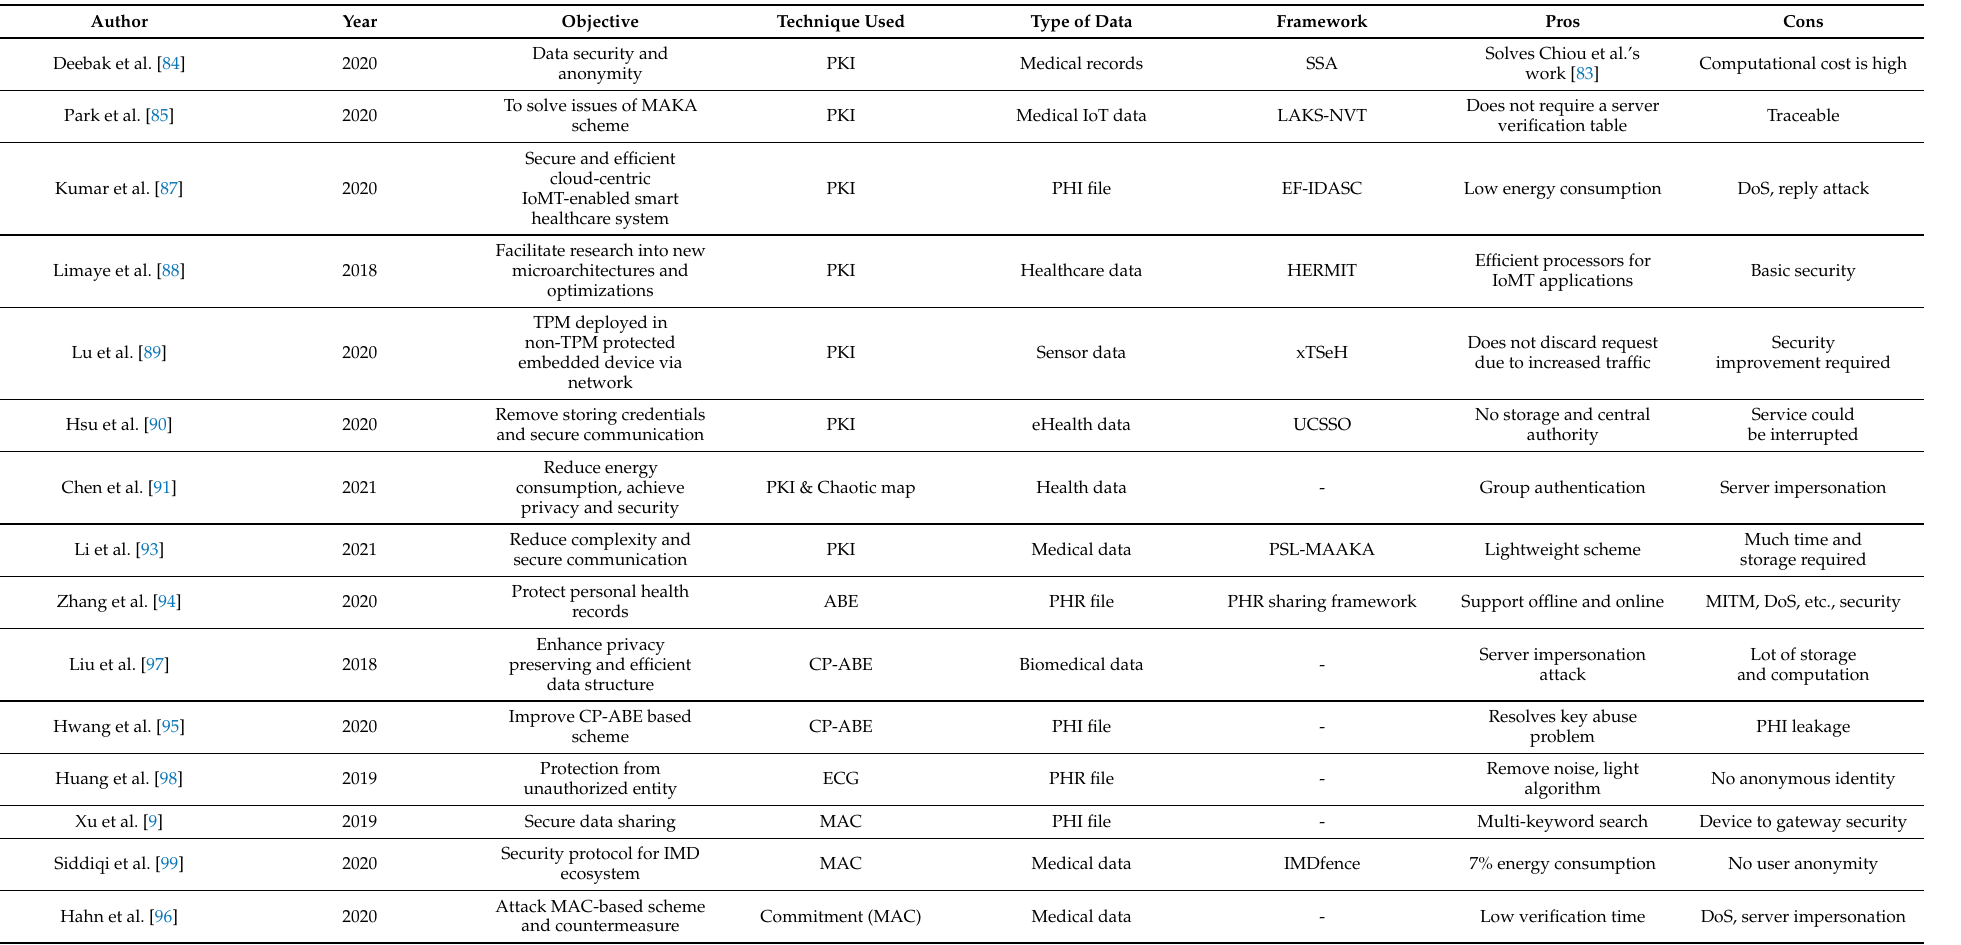
Table 2. Comparative analysis of IoMT security schemes (centralized